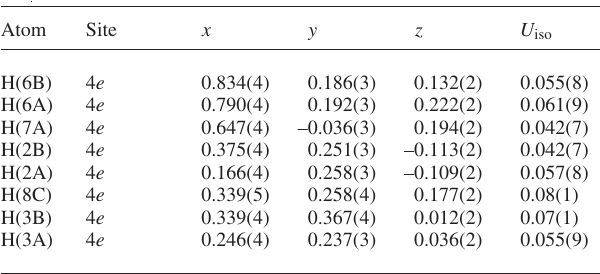
Table 2. Atomic coordinates and displacement parameters (in Å 2 )